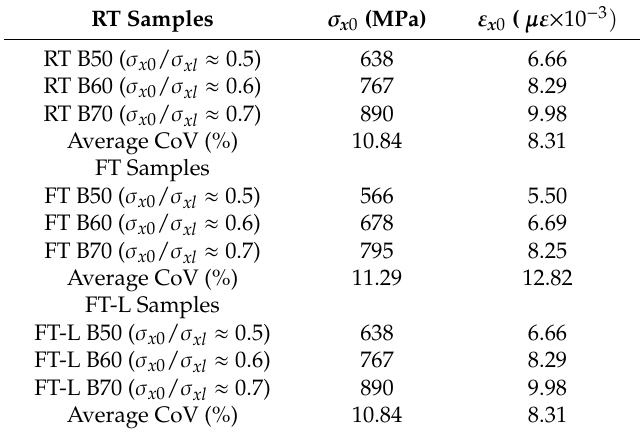
Table 2. The average values of di ff erent stress levels and corresponding strain for each samples used in this creep test.